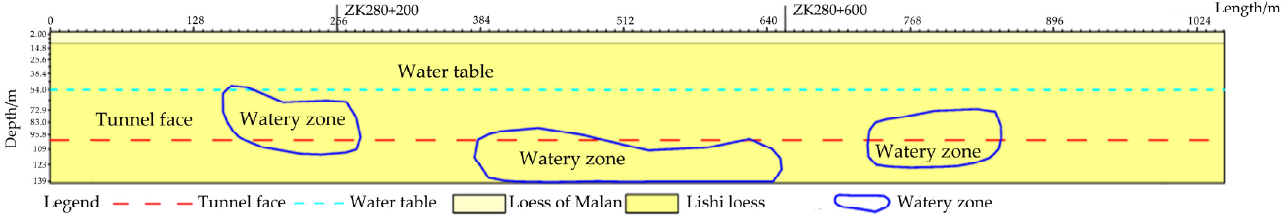
Figure 3. Map of groundwater distribution in longitudinal section of tunnel.